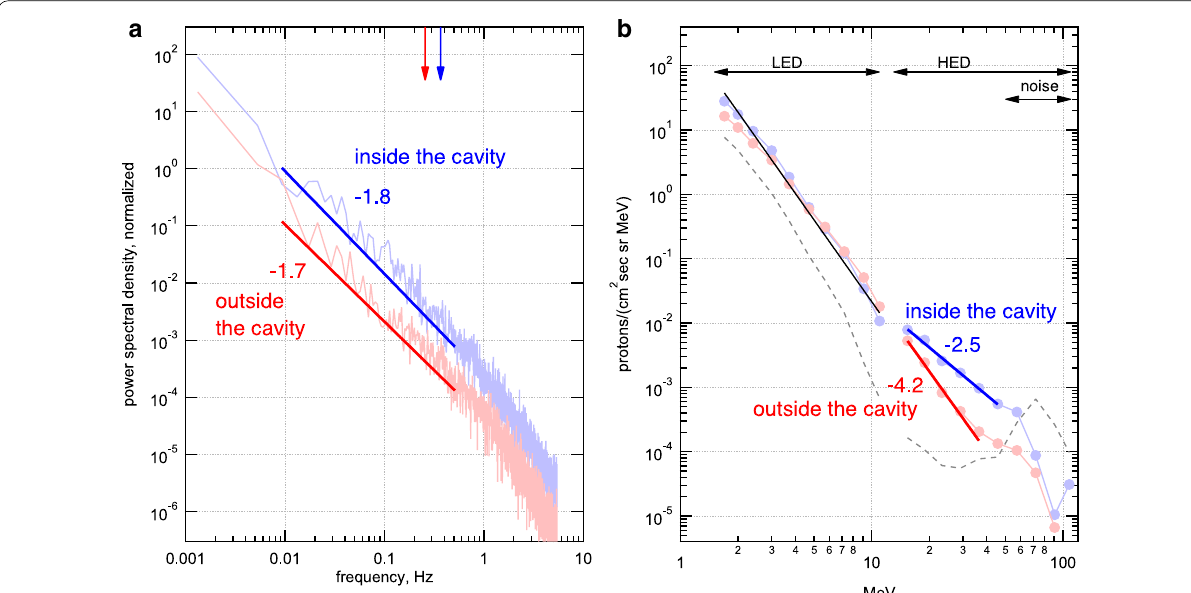
Fig. 5 Magnetic field frequency spectra (left) and proton energy spectra (right) before (red) and during (blue) the observation of the magnetic cavity, providing additional perspective of the proton spike event. The frequency spectra are obtained from the GSE-z component of the magnetic field measured by the Wind spacecraft during 20:27:30–22:54:00 UT (outside the cavity; pink), and 23:20:30–24:33:00 (inside the cavity; light blue) of 4 June 2011. The ion cyclotron frequencies are indicated with the arrows. The energy spectra are obtained by the Low and High Energy Detectors of SOHO/ERNE during 22:00–23:00 UT (outside the cavity; red) and 22:00–23:00 UT (inside the cavity; blue). The background spectrum is obtained from a pre-SEP time period, i.e., 19:00–22:00 UT of 3 June 2011 (dashed curve) and is subtracted from the shown spectra. In both panels, both the power-law fit and spectral index are shown for each spectrum. The two proton energy spectra are almost identical below 10 MeV and have the power-law index of 4.2 (black −